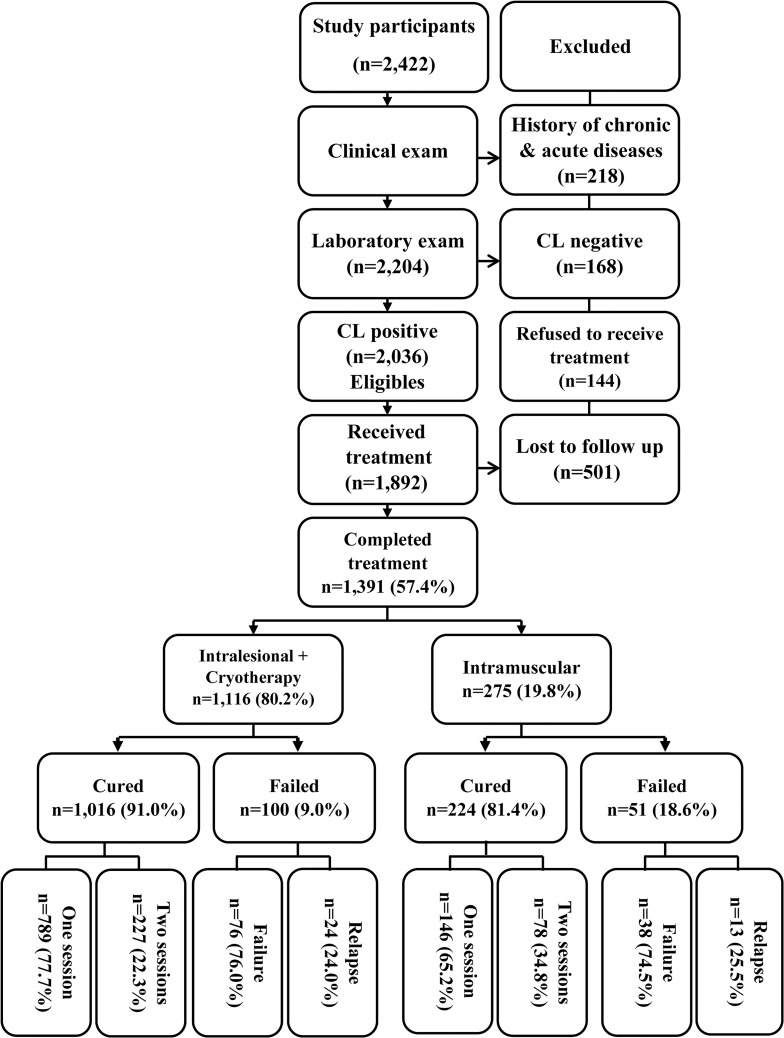
Screening profile and treatment outcome.